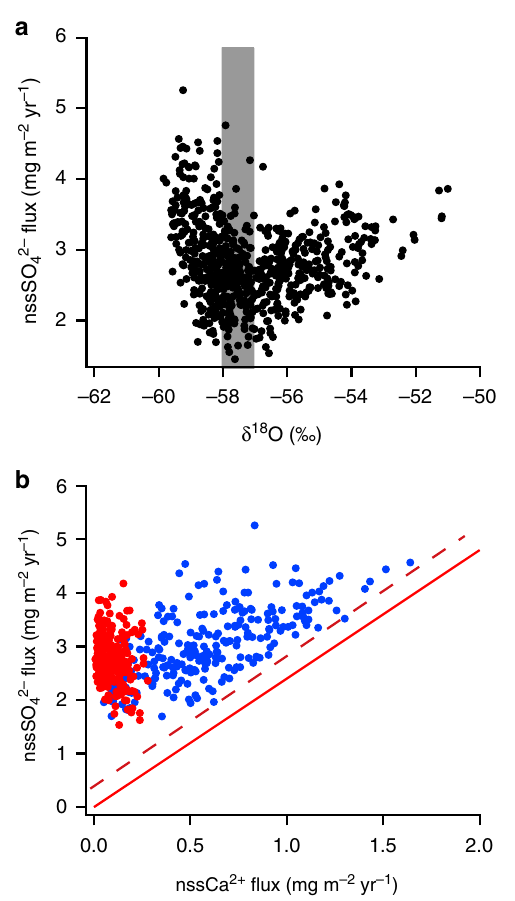
Fig. 2 Variability of nssSO 4 2 − fl ux at Dome Fuji (DF). a DF nssSO 4 2 − fl ux plotted against DF δ 18 O 14,15 . Data points represent 1000-year averages. Before averaging, the δ 18 O depths that differ from the ion data depths have been interpolated to match. Gray bar indicates the lower threshold of δ 18 O ( − 58 ‰ ), below which the nssSO 4 2 − fl ux decreases with δ 18 O, and the upper threshold ( − 57 ‰ ), above which the nssSO 4 2 − fl ux increases with δ 18 O. b DF nssSO 2 − fl ux plotted against DF nssCa 2 + fl ux. Data points 4 represent 1000-year averages. The slope of the solid red line (m = 2.4) represents the stoichiometric mass ratio of Ca/SO 4 as CaSO 4 . The dashed red line shows the lower bound of the nssSO 4 2 − fl ux data with m = 2.4. Red and blue dots represent the data for warm and cold periods, respectively, corresponding to the δ 18 O values above and below the